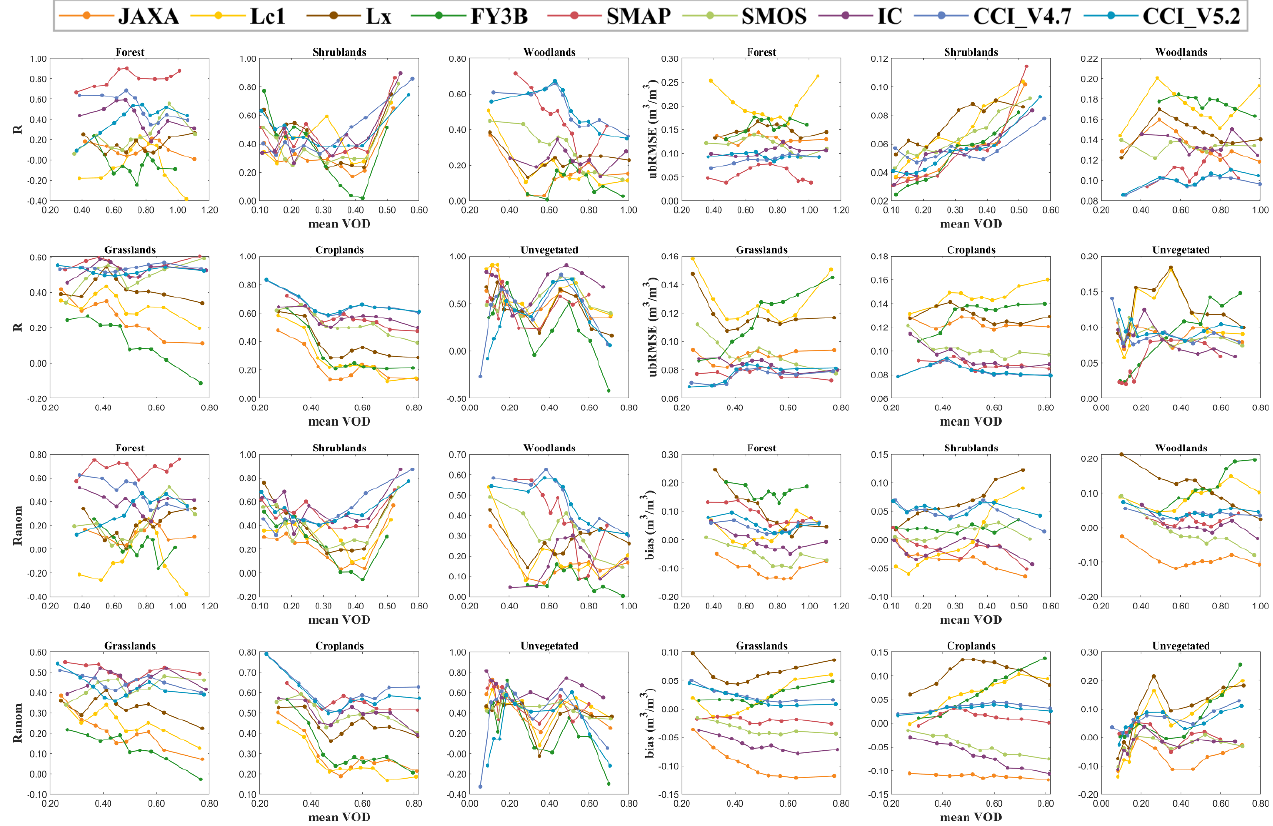
Figure 12. Same as Figure 10 but with varying VOD.